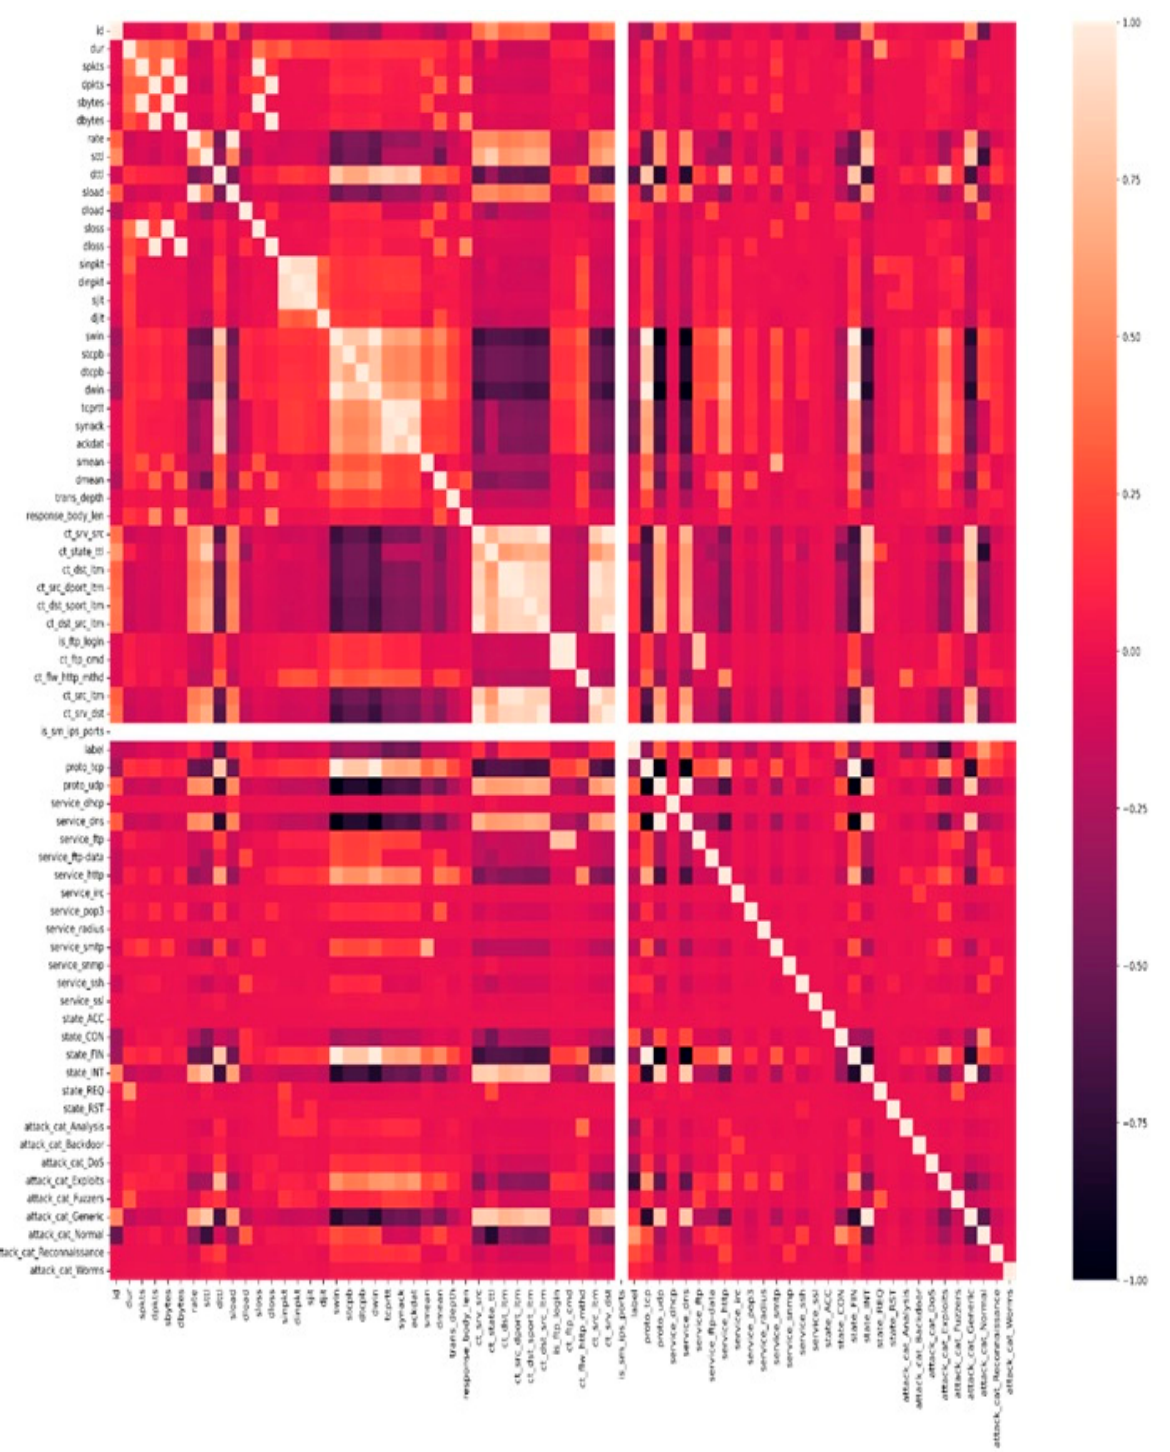
Figure 6. Correlation matrix of the multiclass dataset.